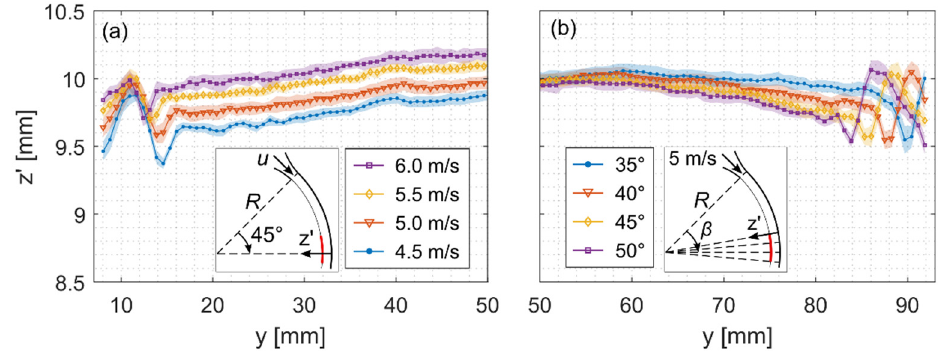
Figure 6. ( a ) Height profiles at the vertical channel position β = 45° at different flow velocities u . ( b ) Height profiles at u = 5 m/s at different circumferential positions ( β ).